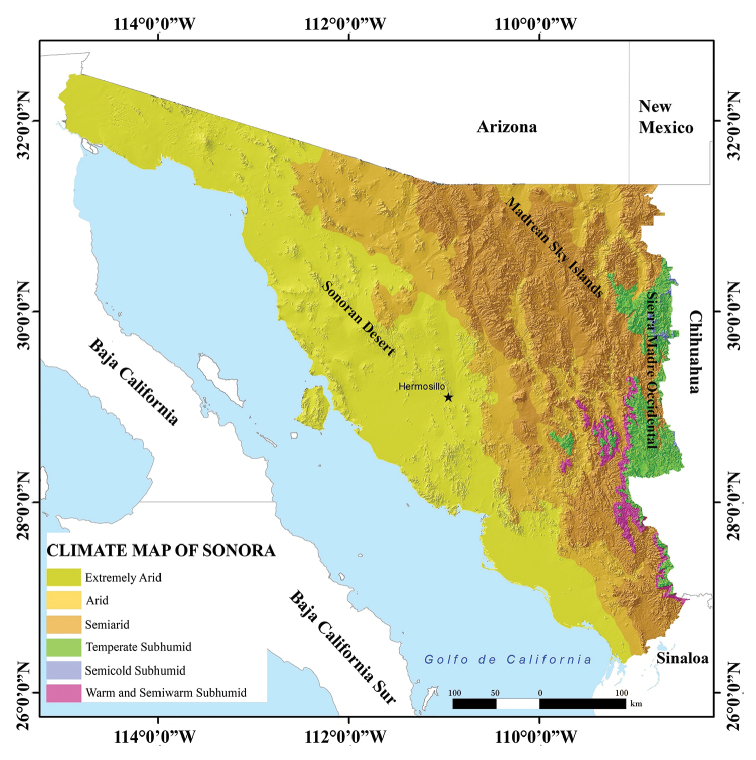
Climate map of the state of Sonora, Mexico (modified from García – CONABIO 1998).